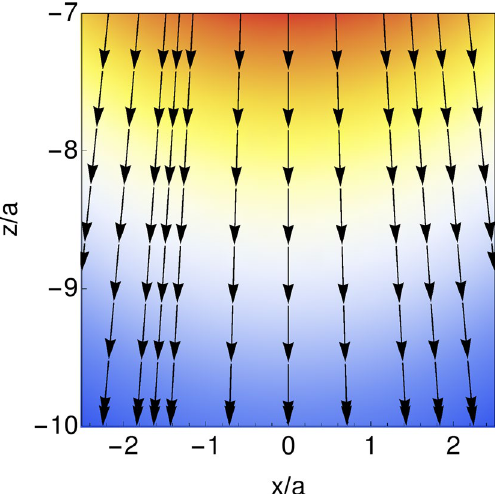
0 , Ca 0.1 and h / a = =